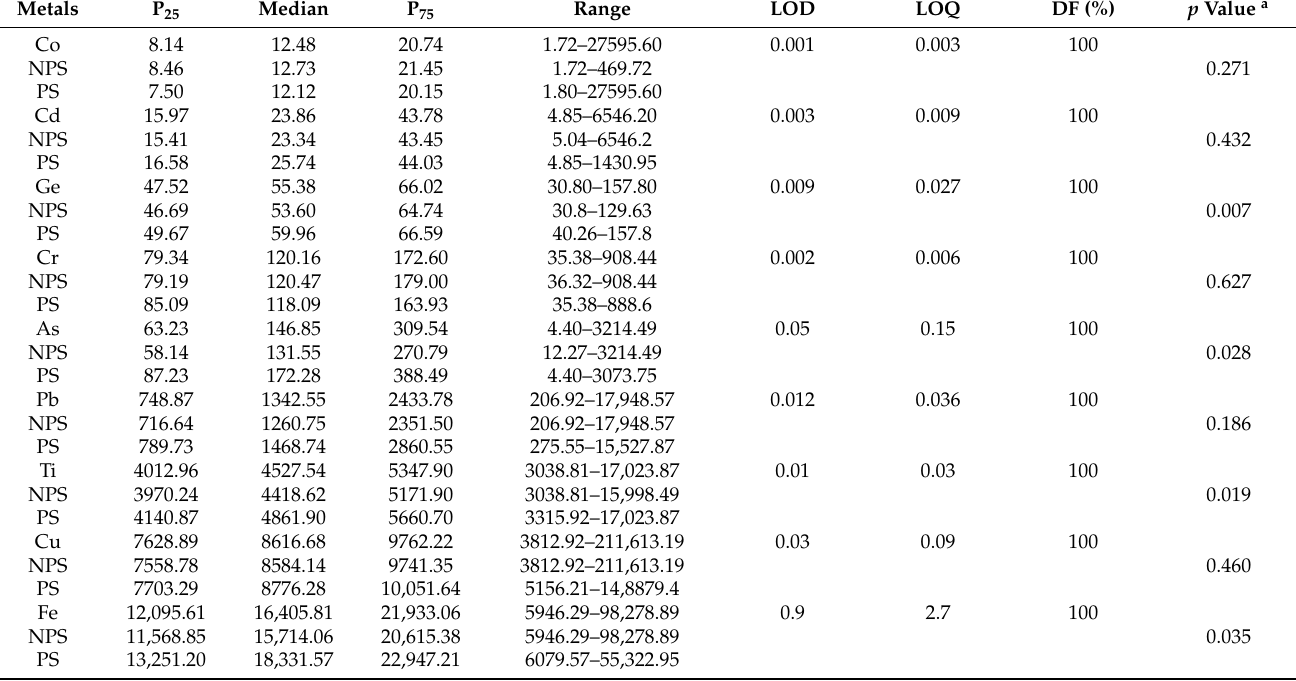
Table 2. Hair heavy metal concentrations (ng/g) of passive smoking women and non-passive smoking